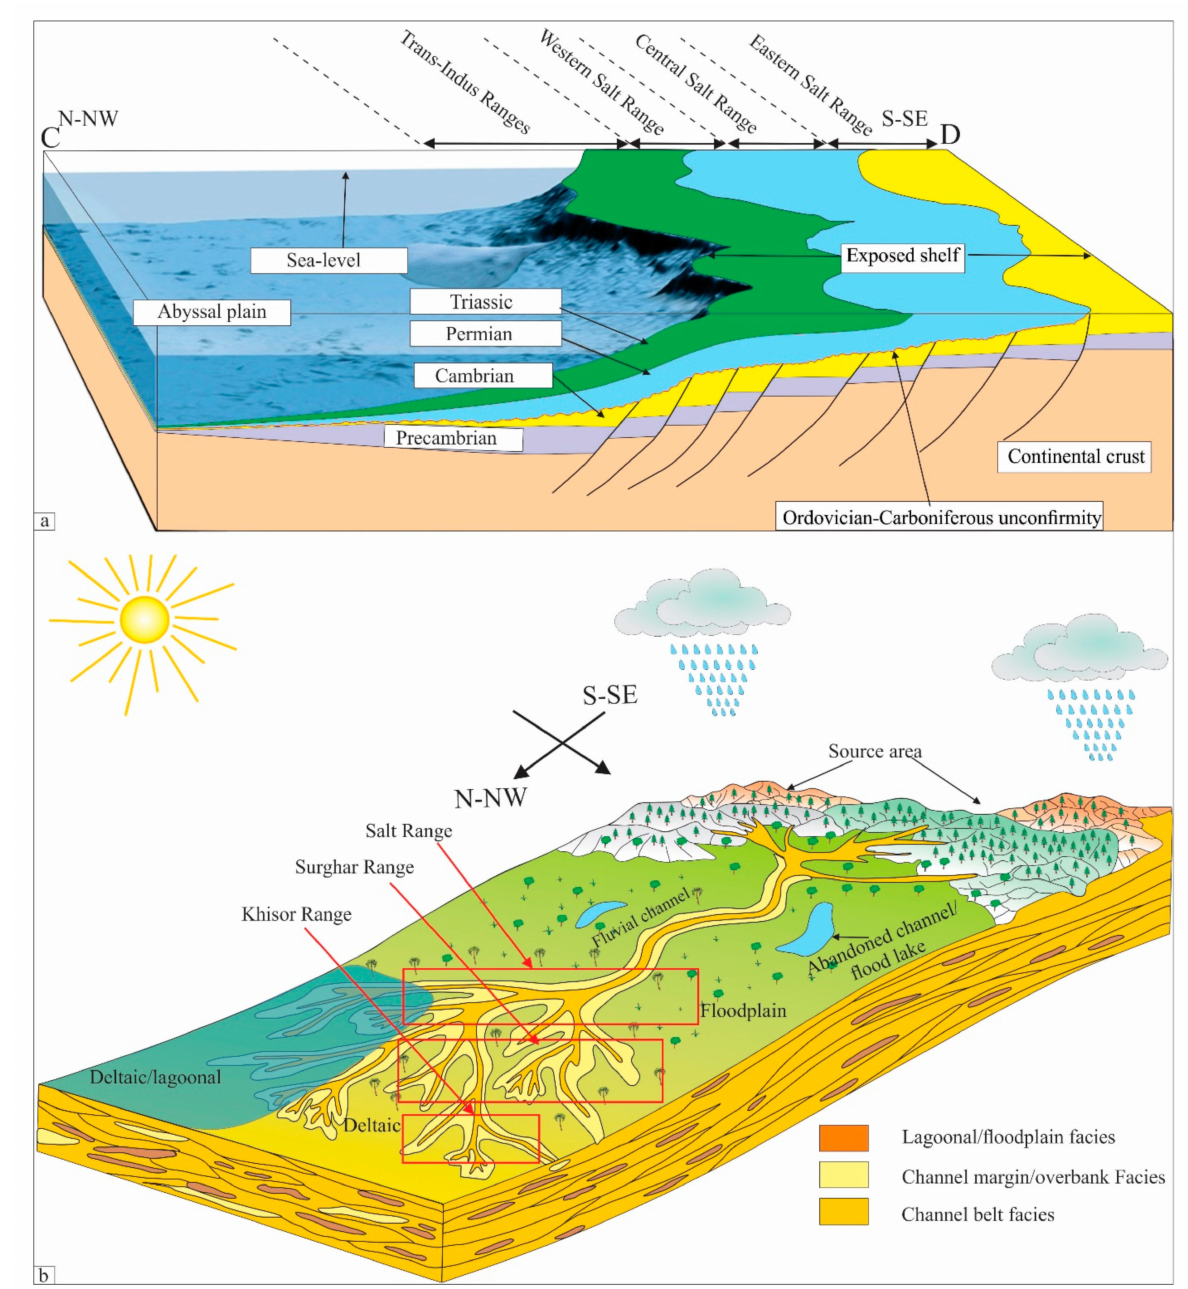
Figure 17. ( a ) A cross-sectional C–D (see Figure 16 for location) view of the northwestern margin of the Indian Plate ca. 200 Ma ago; ( b ) source to sink transport model for the Upper Triassic–Lower Jurassic siliciclastics in the Salt and Trans–Indus ranges. Note: both models are not to